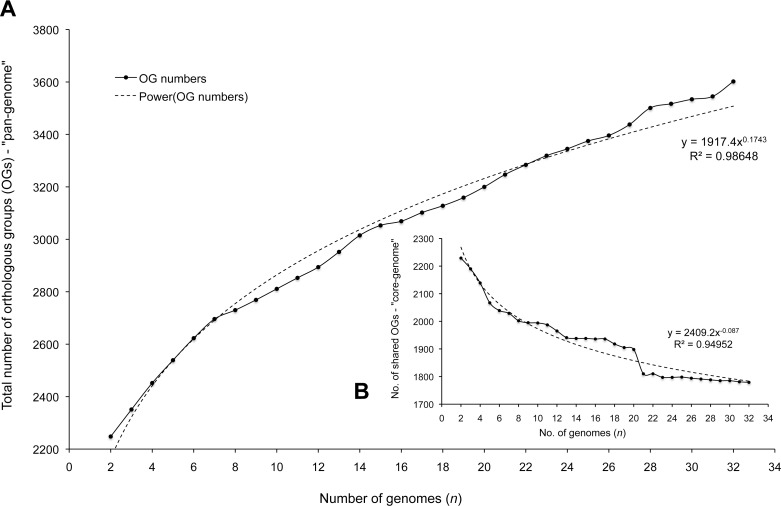

S. aureus pan- and core-genome.Saturation plots depicting the pan- and core-genome sizes of S. aureus as estimated by plotting as a function of the number of genomes (n), the accumulation of (A) the total number of unique orthologous groups (OGs) and (B) the number of shared OGs. A total of 32 genomes were evaluated with the accumulation of OG numbers (solid lines) also fit by power curves (broken lines) and the respective equations and R2 values inset.